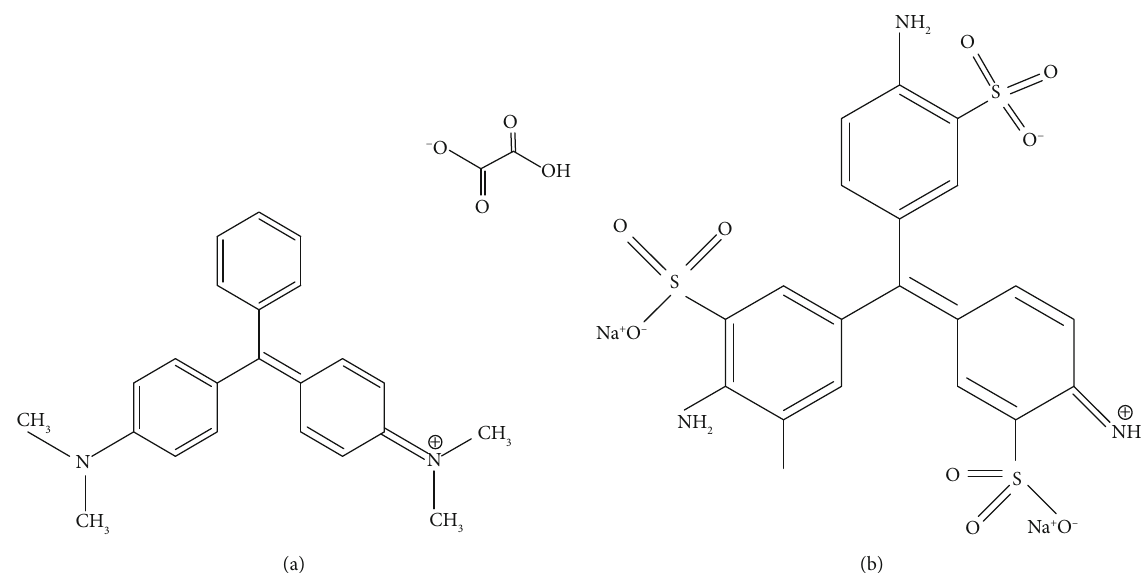
Figure 1: Molecular structure of (a) basic green 4 dye and (b) acid